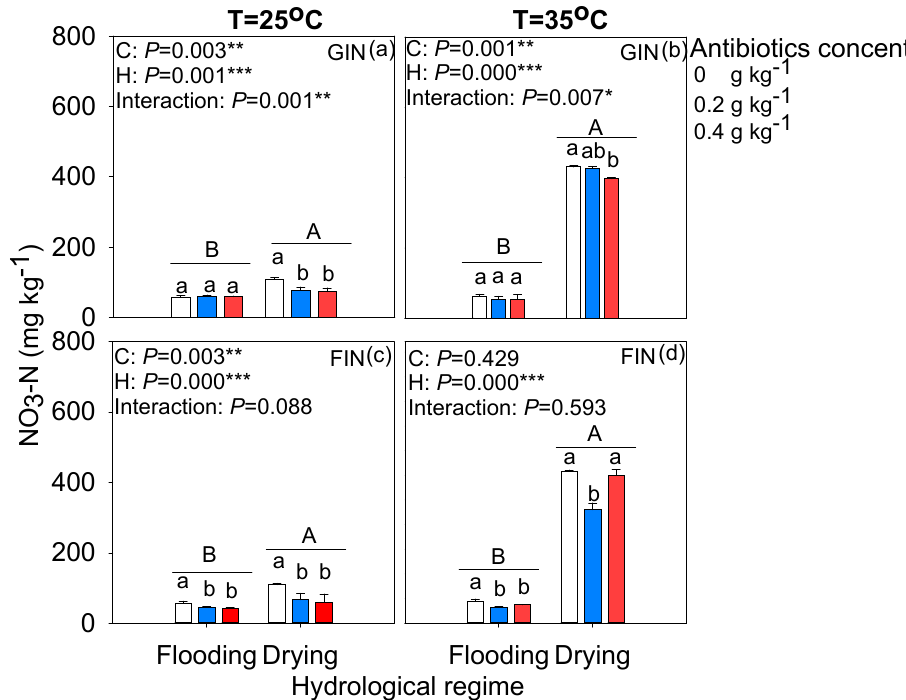
Figure 2. The variation of nitrate at 25 °C and 35 °C during 30 − day flooding or drying incubation. Different uppercase letters indicate significant differences between flooding and drying. Different lowercase letters represent significant differences among antibiotics concentration under flooding or drying conditions. Different numbers of asterisks represent a significant difference (* p < 0.05, ** p < 0.01, *** p < 0.001).